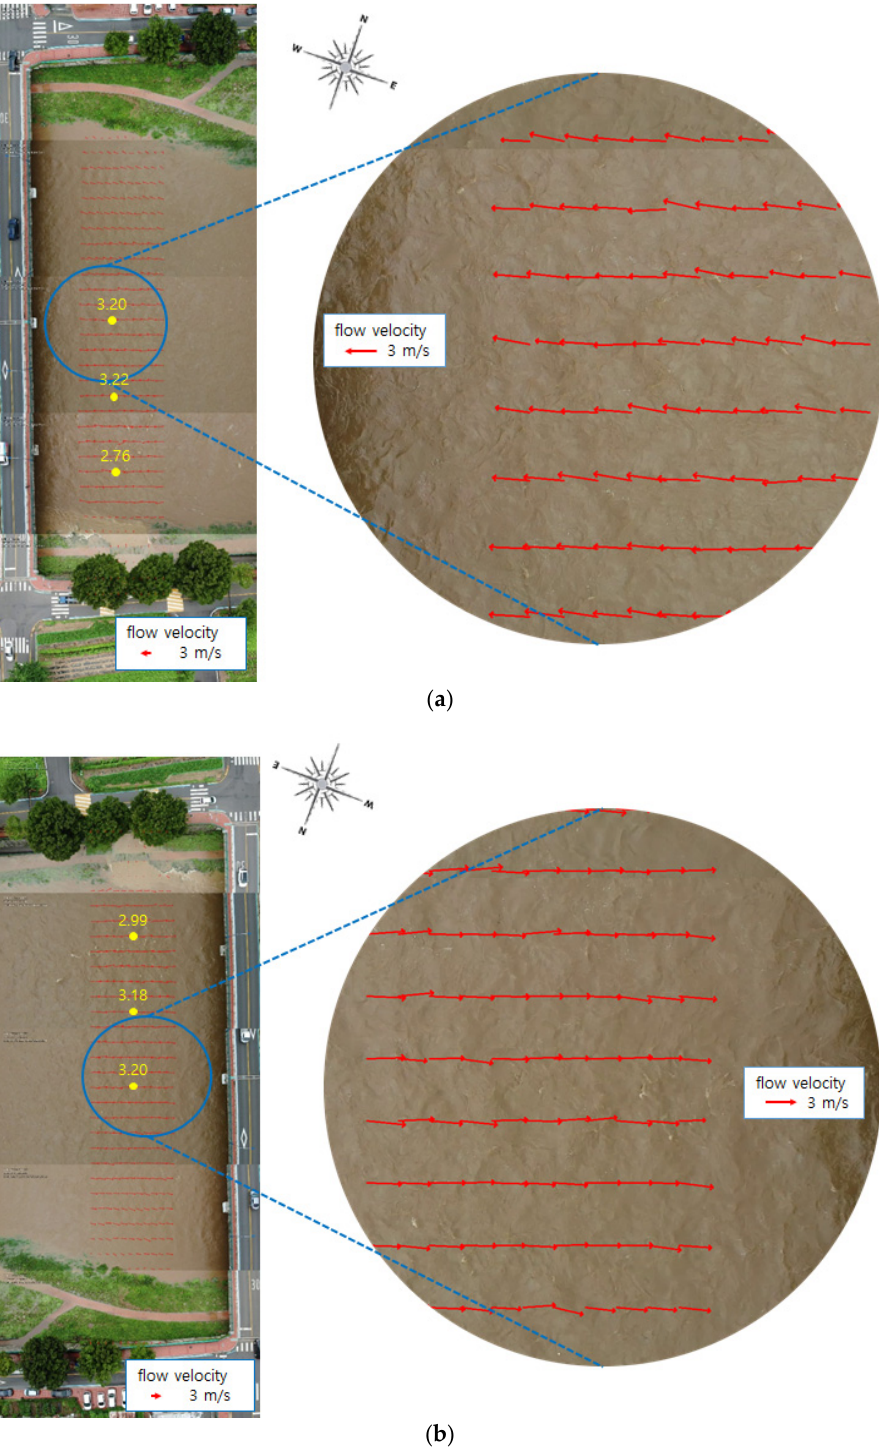
Figure 9. Velocity fields (Mujudaegyo Bridge) measured with the navigating drone method: ( a ) flight from south to north; ( b ) flight from north to south. (The numbers representing flow velocity were added later for reference.)